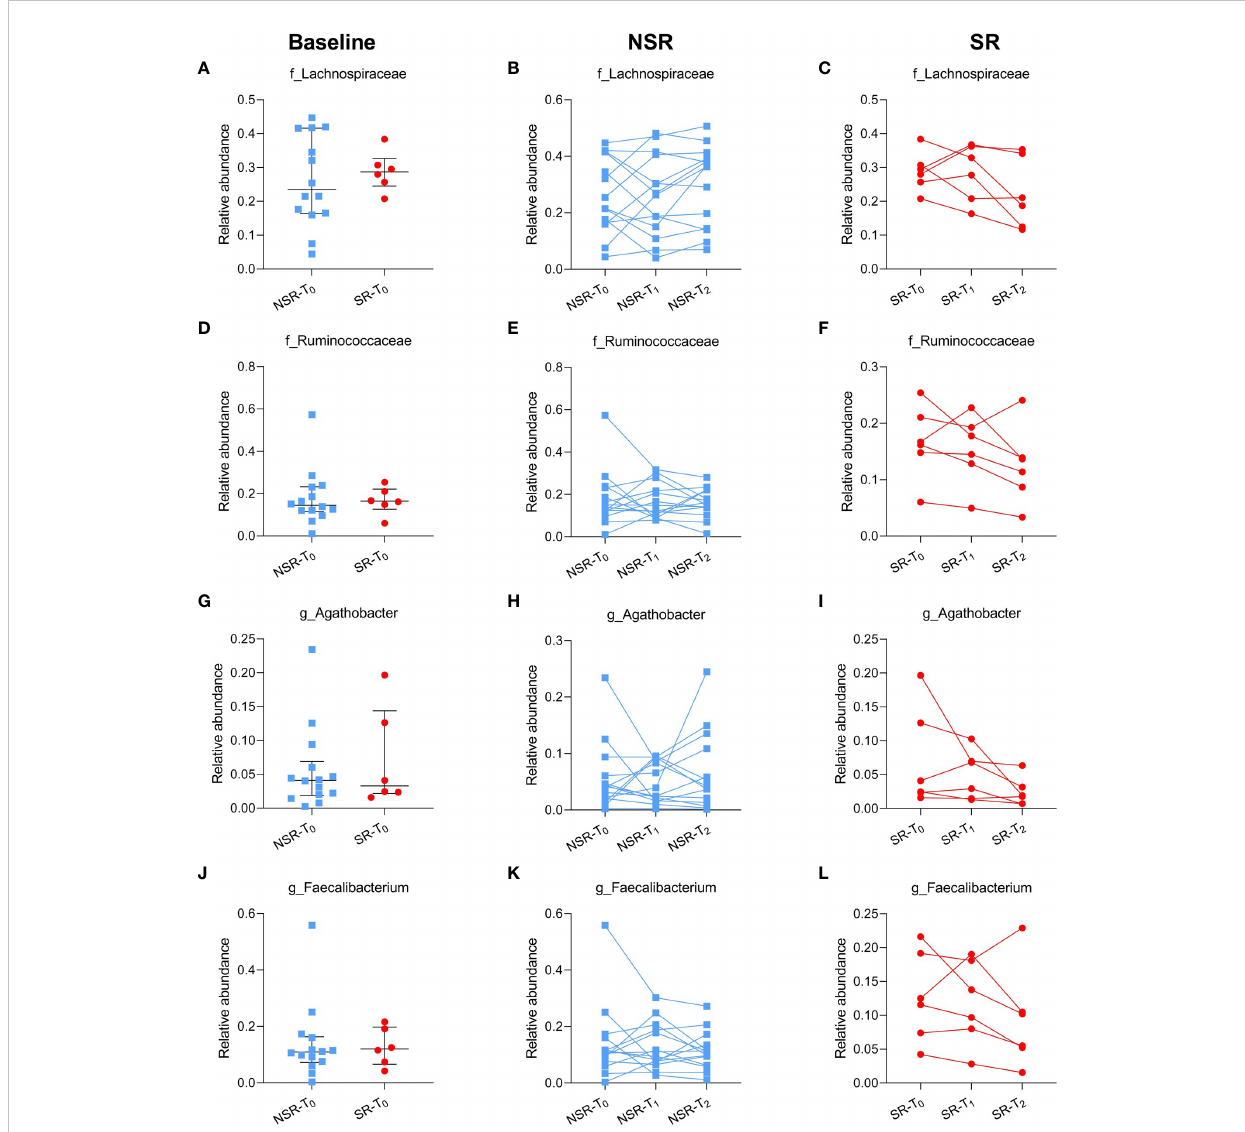
FIGURE 4 The relative abundance of reported microbiomes bene fi cial to ICI ef fi cacy in patients with/without secondary resistance. The relative abundance of baseline (A) and individual changes in the Lachnospiraceae family in NSR patients (B) and SR patients (C) ; baseline (D) and individual changes in the Ruminococcaceae family in NSR patients (E) and SR patients (F) ; baseline (G) and individual changes in the Agathobacter genus in NSR patients (H) and SR patients (I) ; baseline (J) and individual changes in the Faecalibacterium genus in NSR patients (K) and SR patients (L) . Medians and interquartile ranges are indicated. ICI, immune checkpoint inhibitor; NSR, non-secondary resistance; NSR-T 0 , non-secondary resistance patients - before ICI treatment; NSR-T 1 , non-secondary resistance patients - primary response after ICI treatment; NSR-T 2 , non-secondary resistance patients - durable response after ICI treatment; SR, secondary resistance; SR-T 0 , secondary resistance patients - before ICI treatment; SR-T 1 , secondary resistance patients - primary response after ICI treatment; SR-T 2 , secondary resistance patients - secondary resistance after ICI